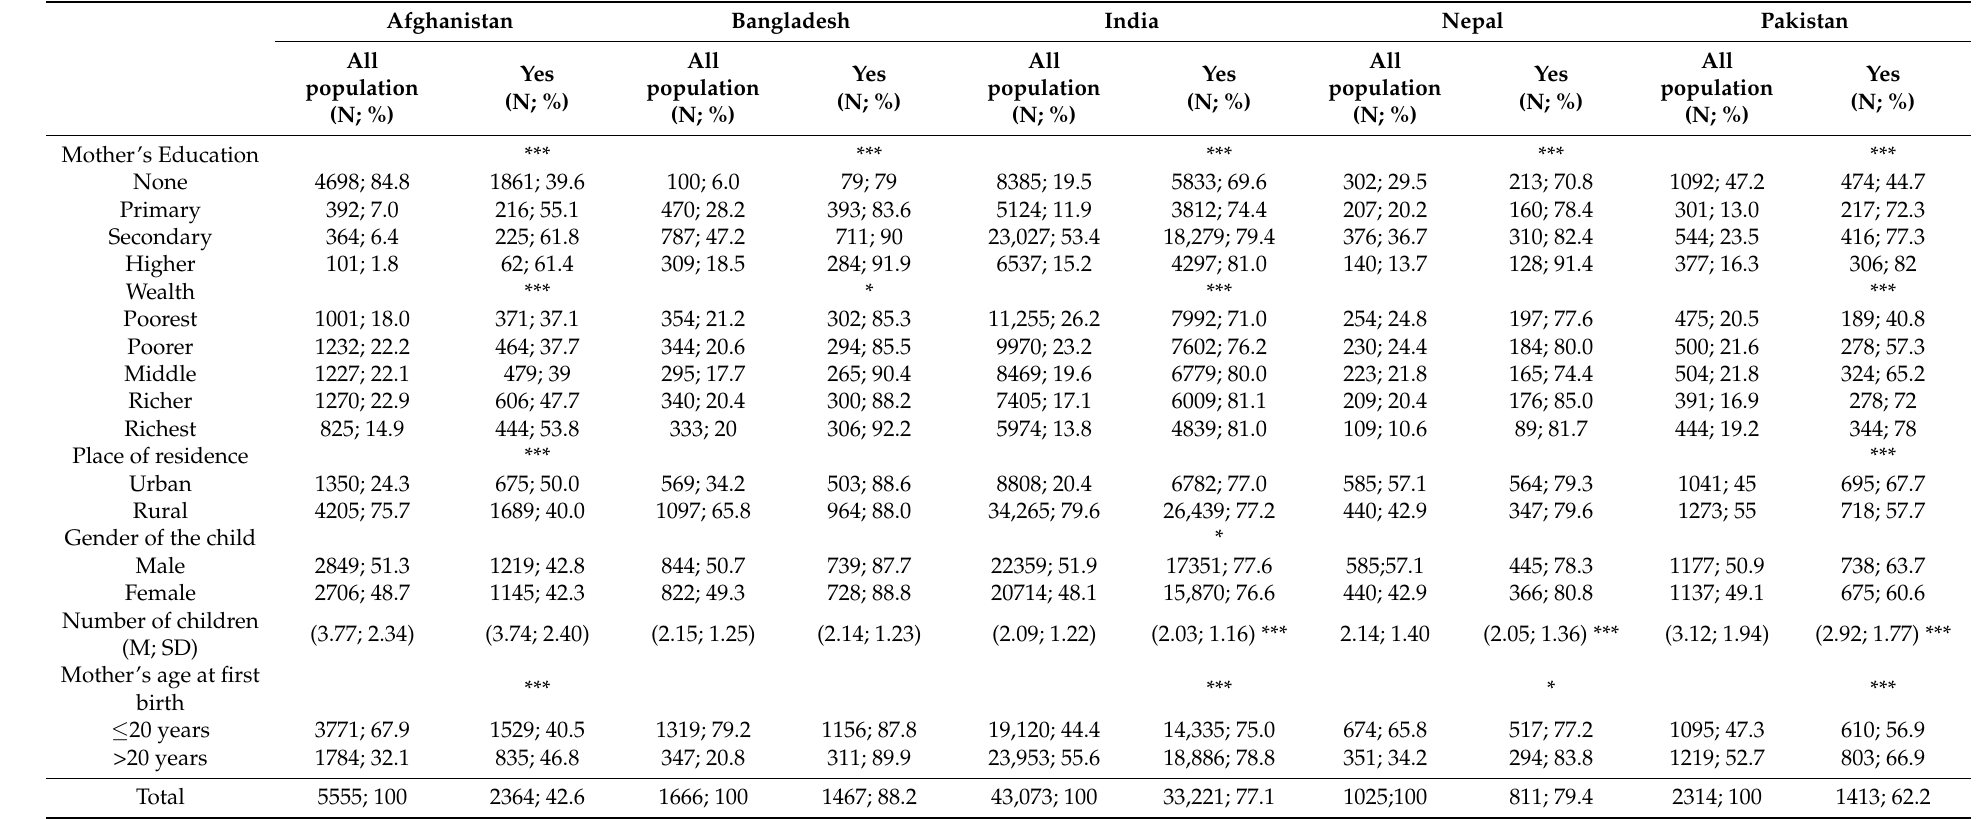
Table 1. Descriptive characteristics of the sample and bivariate association between independent variables and full immunisation. Afghanistan Bangladesh India Nepal